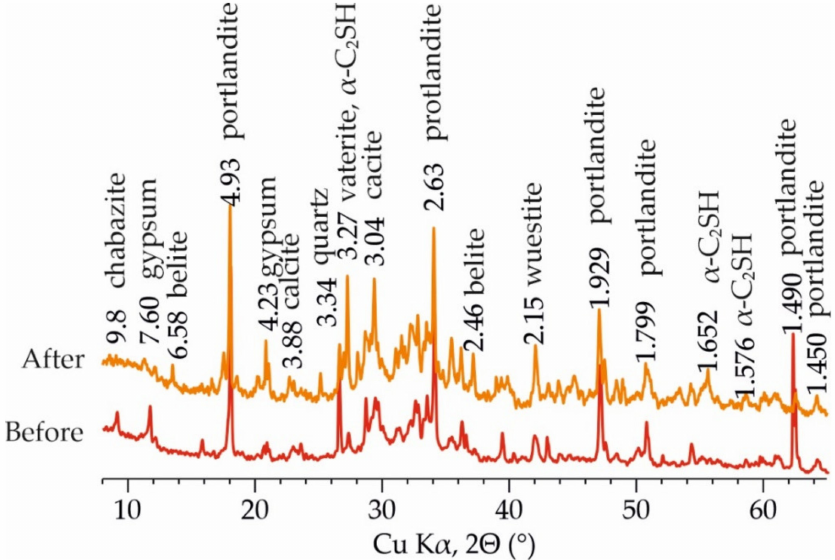
Figure 4. X-ray diffraction patterns of the concrete samples before and after